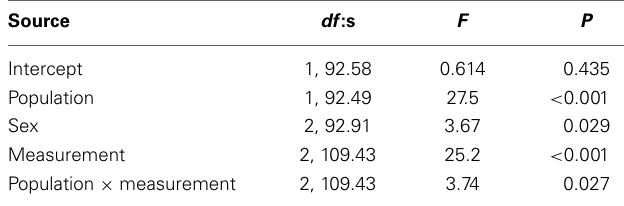
Table 2 | Significance of fixed factors in explaining variance in boldness score according to linear mixed effect